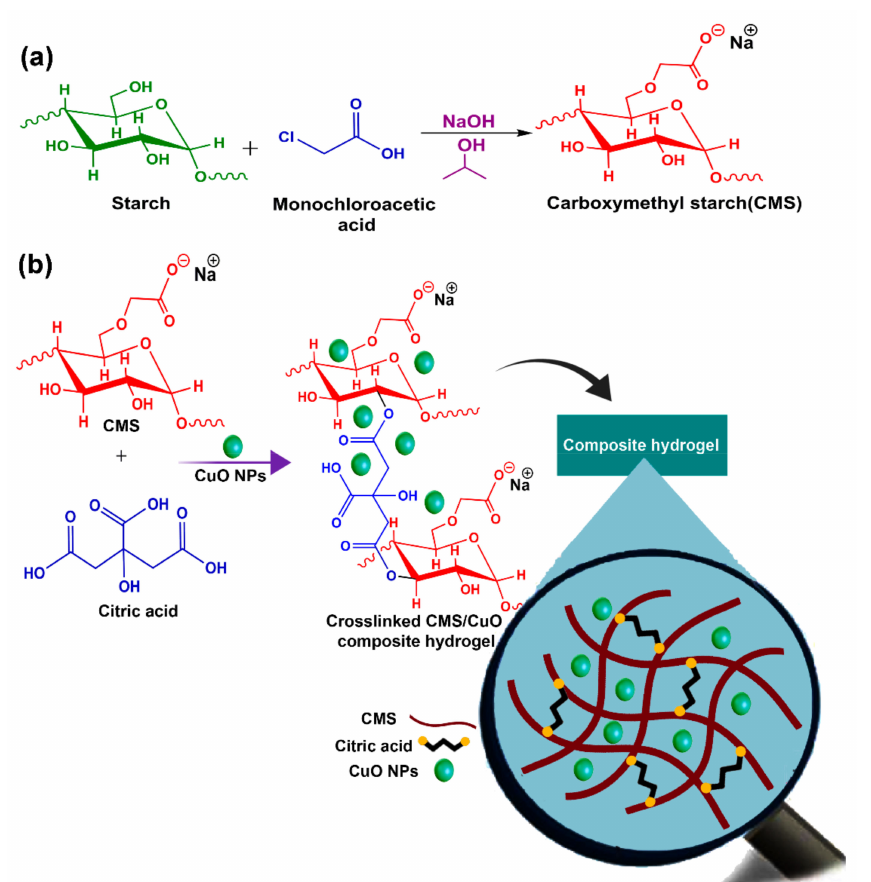
Figure 9. Schematic of the preparation of ( a ) sodium carboxymethyl starch (CMS) and ( b ) nanocom- posite hydrogels that consists of CuO nanoparticles (NPs) dispersed within the citric acid crosslinked CMS polymer